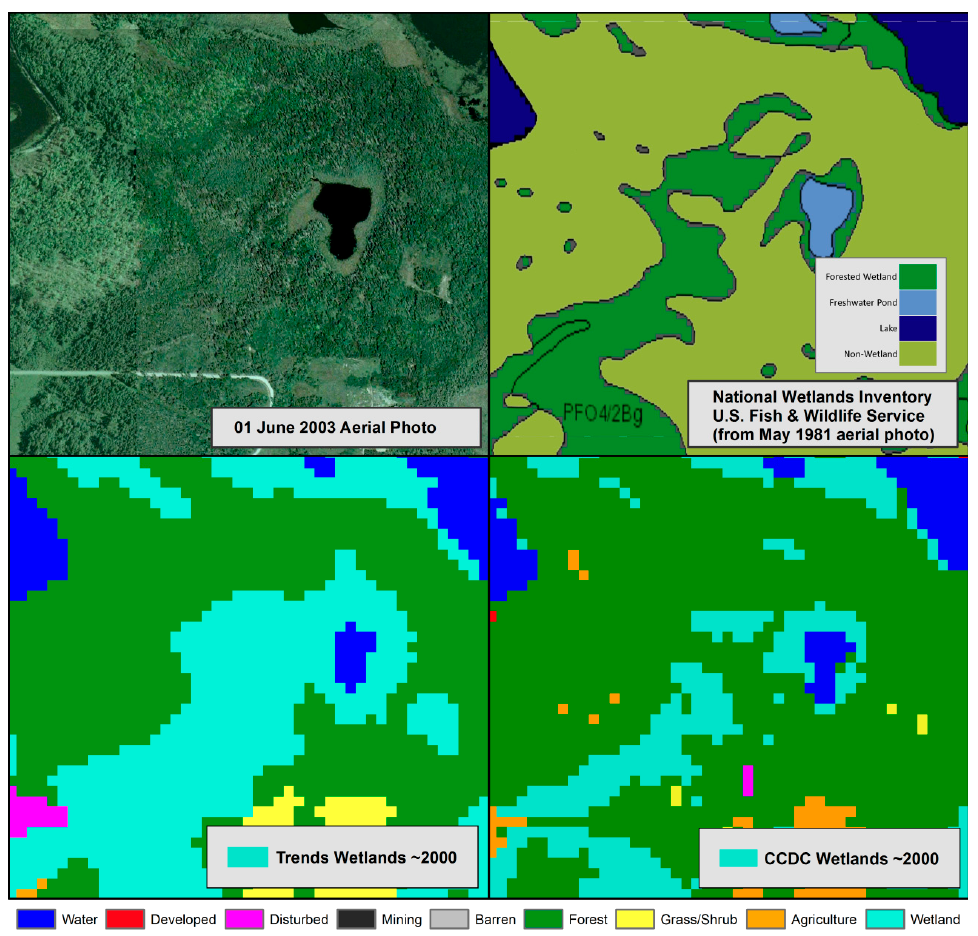
Figure 7. Comparison of CCDC and LC Trends Wetland classes with National Wetlands Inventory (NWI) data and high resolution imagery.